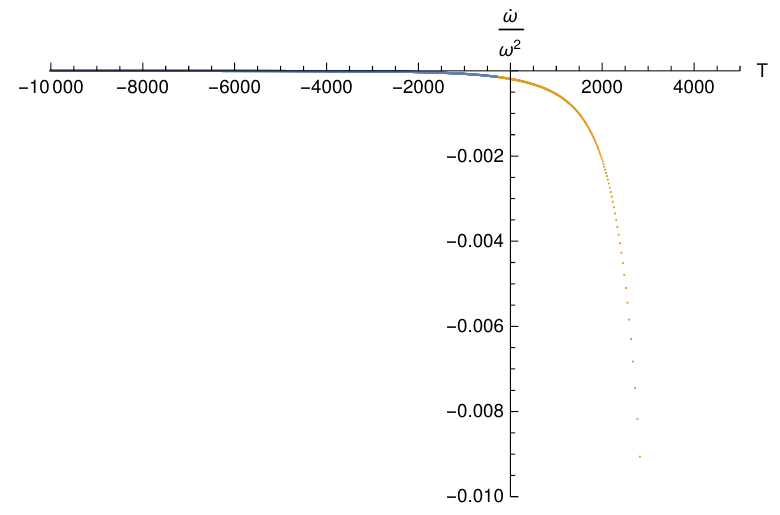
Figure 3 . The blue (orange) segment corresponds to _ !=! 2 as seen by the second infalling D0 brane from outside (inside) the horizon. Note that the D0 brane can get well inside the horizon while still being within the WKB regime ( _ !=! 2 . O (10 (cid:0) 3 )), therefore, we still trust the WKB estimate past the horizon. The parameters used are the same ones as in (cid:12)gure